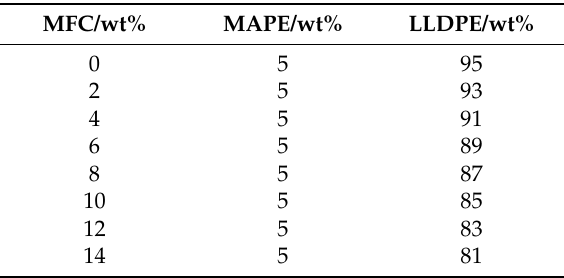
Table 1. Formulation of MFC/LLDPE mixed extrusion